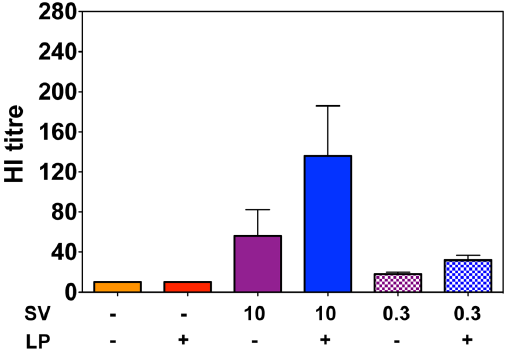
Fig. 4. HI titer of serum from mice vaccinated by the i.n. route. Mice were immunized once with PBS, 10 nmol lipopeptide (LP), 10 or 0.3 m g of HA as split virus (SV) or combinations of these as indicated ( + ) by the i.n. route. Sera sampled one month later were tested for HI activity against the homologous virus. Bars represent the mean HI titers for groups of 5 mice and error bars indicate the standard error of the mean. Titers of , 10, observed for all animals in the PBS and lipopeptide alone groups are designated as 10 for the purposes of statistical